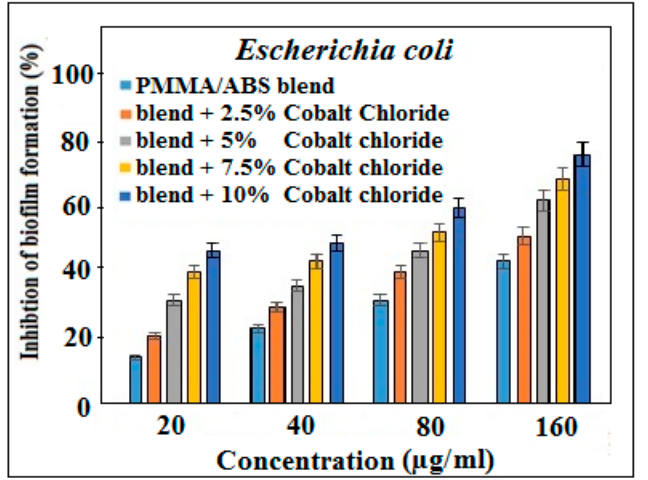
Figure 5. Biofilm inhibition activity of PMMA/ABS and PMMA/ABS/different concentrations of CoCl 2 in DMSO, p < 0.05 vs. control.